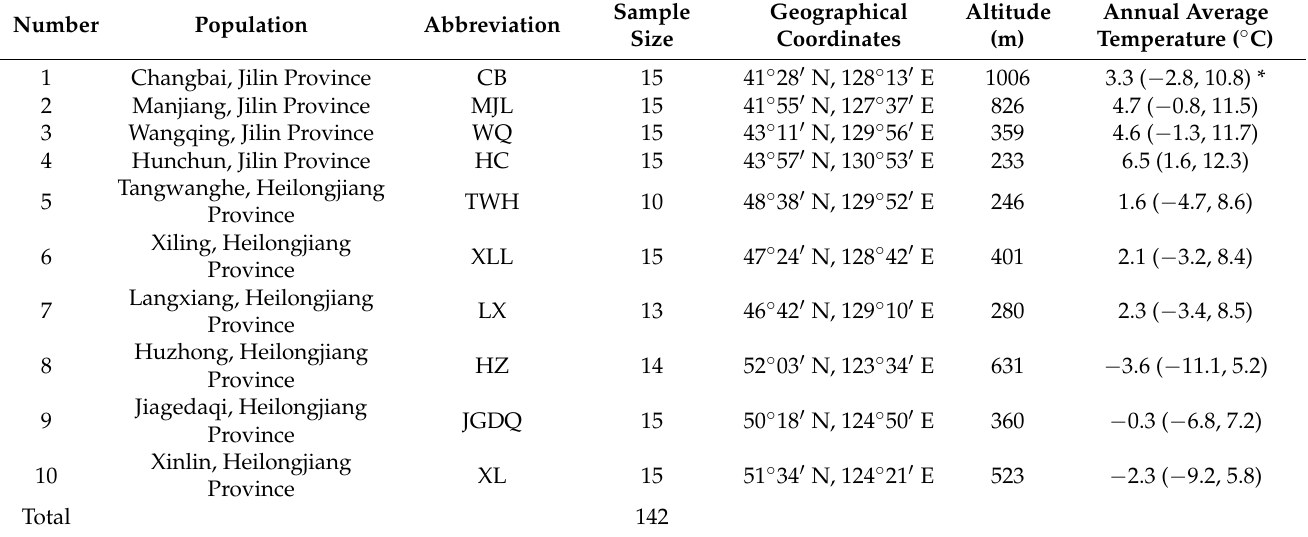
Table 1. Details of